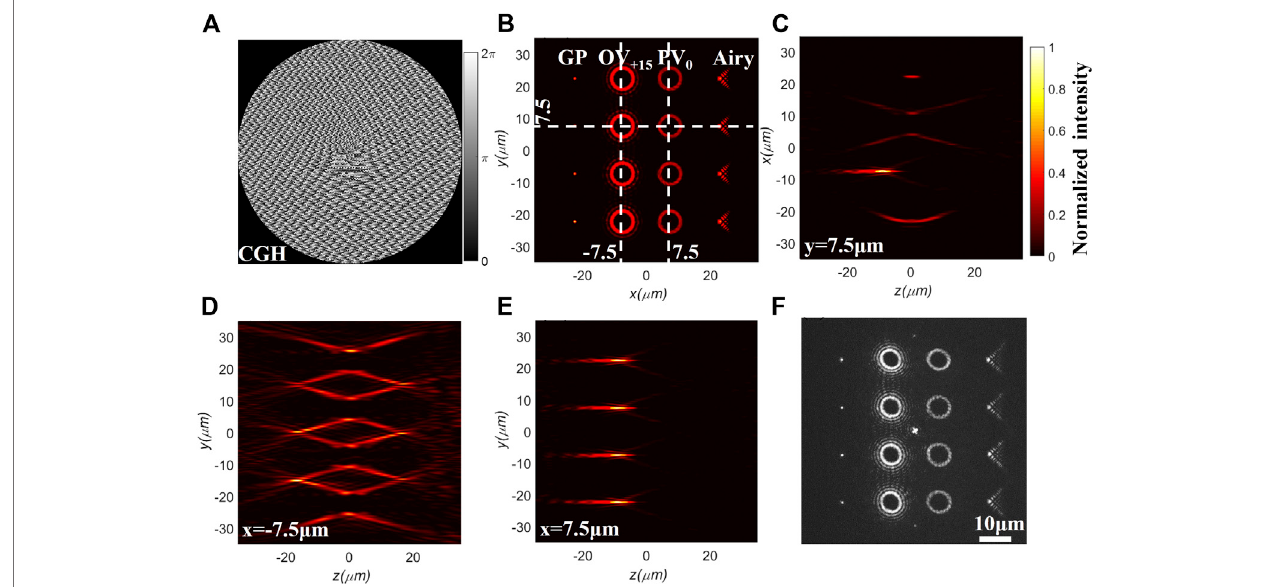
FIGURE5| Anarraycomposedoffourtypesofopticaltraps:GPs,OVs,PVs,andAirybeams. (A) HologramaddressedonSLM. (B) Theintensitydistributionofthe xy -planeobtainedbythesimulation. (C) Theintensitydistributionofthe xz -planeobtainedbythesimulationcorrespondingtothedashedline y (cid:1) 7.5 μ min (B) . (D,E) The intensitydistributionsin yz -planeobtainedbysimulationcorrespondingtothe dashed line x (cid:1)− 7.5 μ m and x (cid:1) 7.5 μ min (B) , respectively. (F) Theintensity distribution of the xy- plane obtained from the experiment. The center highlight is the zero-order spot of SLM.